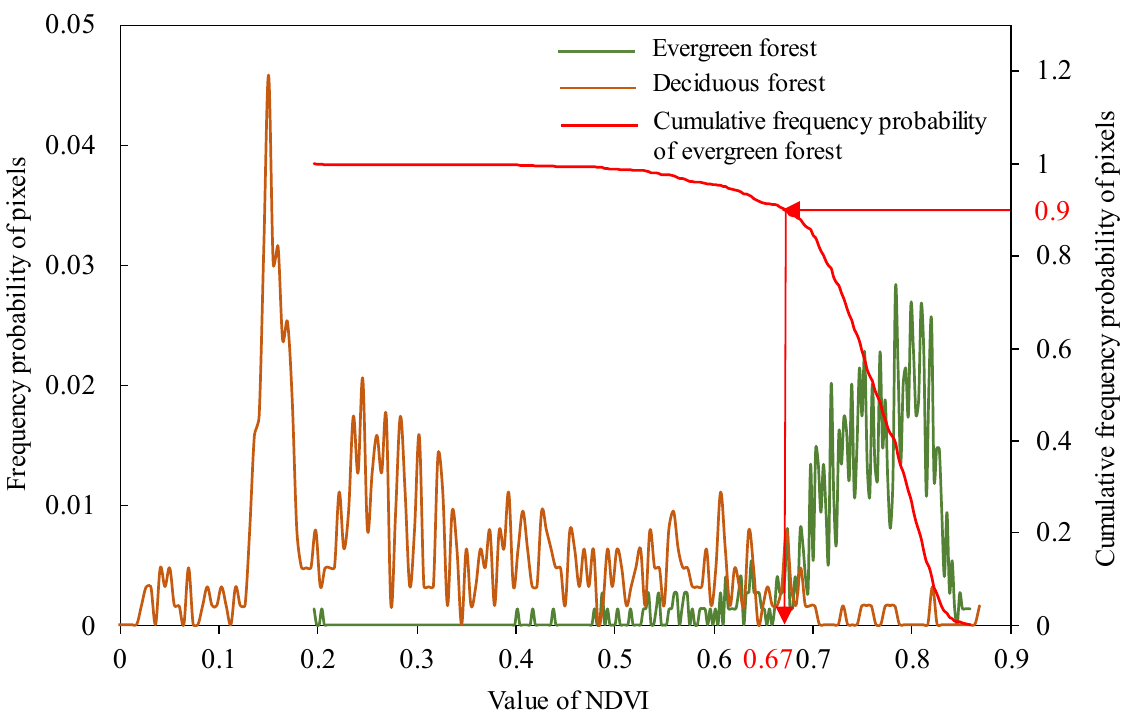
Figure A5. Pixel frequency probability distribution of NDVI values of evergreen and deciduous forest training samples.